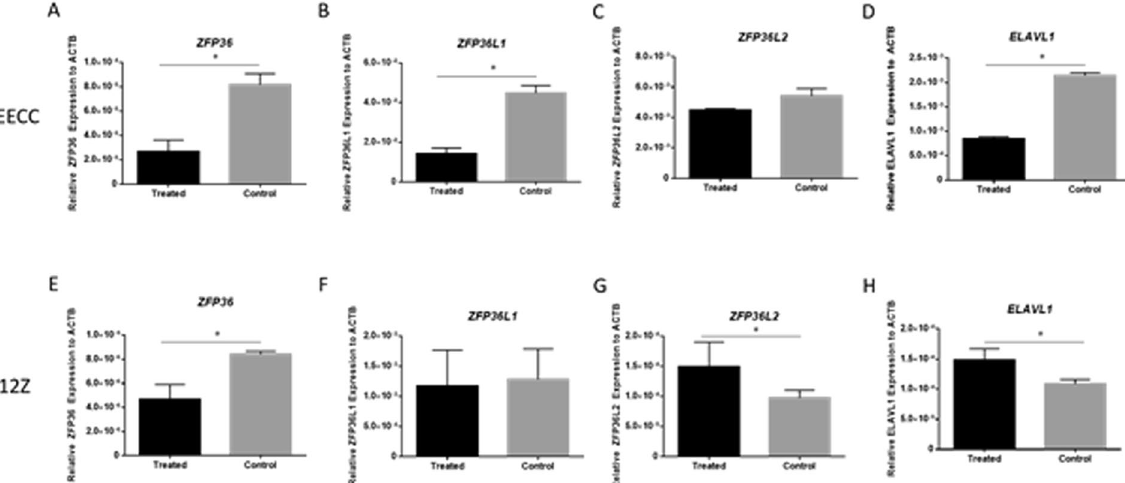
Figure 5. TTP knockdown results in endometriotic (12Z) and endometrial epithelial (EECC)-specific effects in other RNABPs of HuR/TTP axis: Influence of TTP knockdown on TIS11 family and HuR RNA binding proteins in human endometrial epithelial (EECC) and endometriotic (12Z) cells. Transcript ZFP36 which encodes for TTP was significantly lower in both EECC and 12Z cells (Panels A,E). Transcripts for ZFP36L1 and ELAVL1 were also downregulated in EECC cells treated with TTP siRNA (panels B,D). The TTP family member ZFP36L2 did not statistically differ upon knockdown of TTP in EECCs (panel C). On the other hand, transcripts for ZFP36L2 and ELAVL1 were upregulated in 12Z cells treated with TTP siRNA (panels G,H). Transcripts for ZFP36L1 do notstatistically differ when knocked down with TTP siRNA in 12Zs (panel F). Expression data illustrated as mean ± SEM. * P < 0.05. Each group (treated and control) consisted of three wells performed in triplicates. Data is derived from three independent experiments; n =